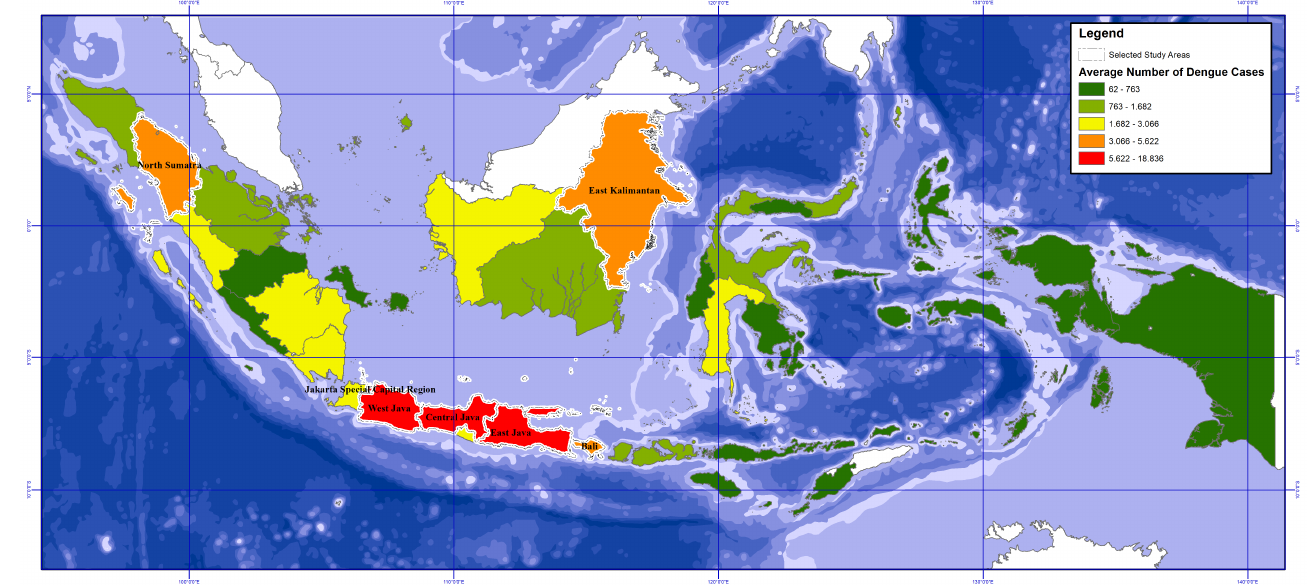
Figure 2. Map of the selected study areas based on the average number of dengue cases in various